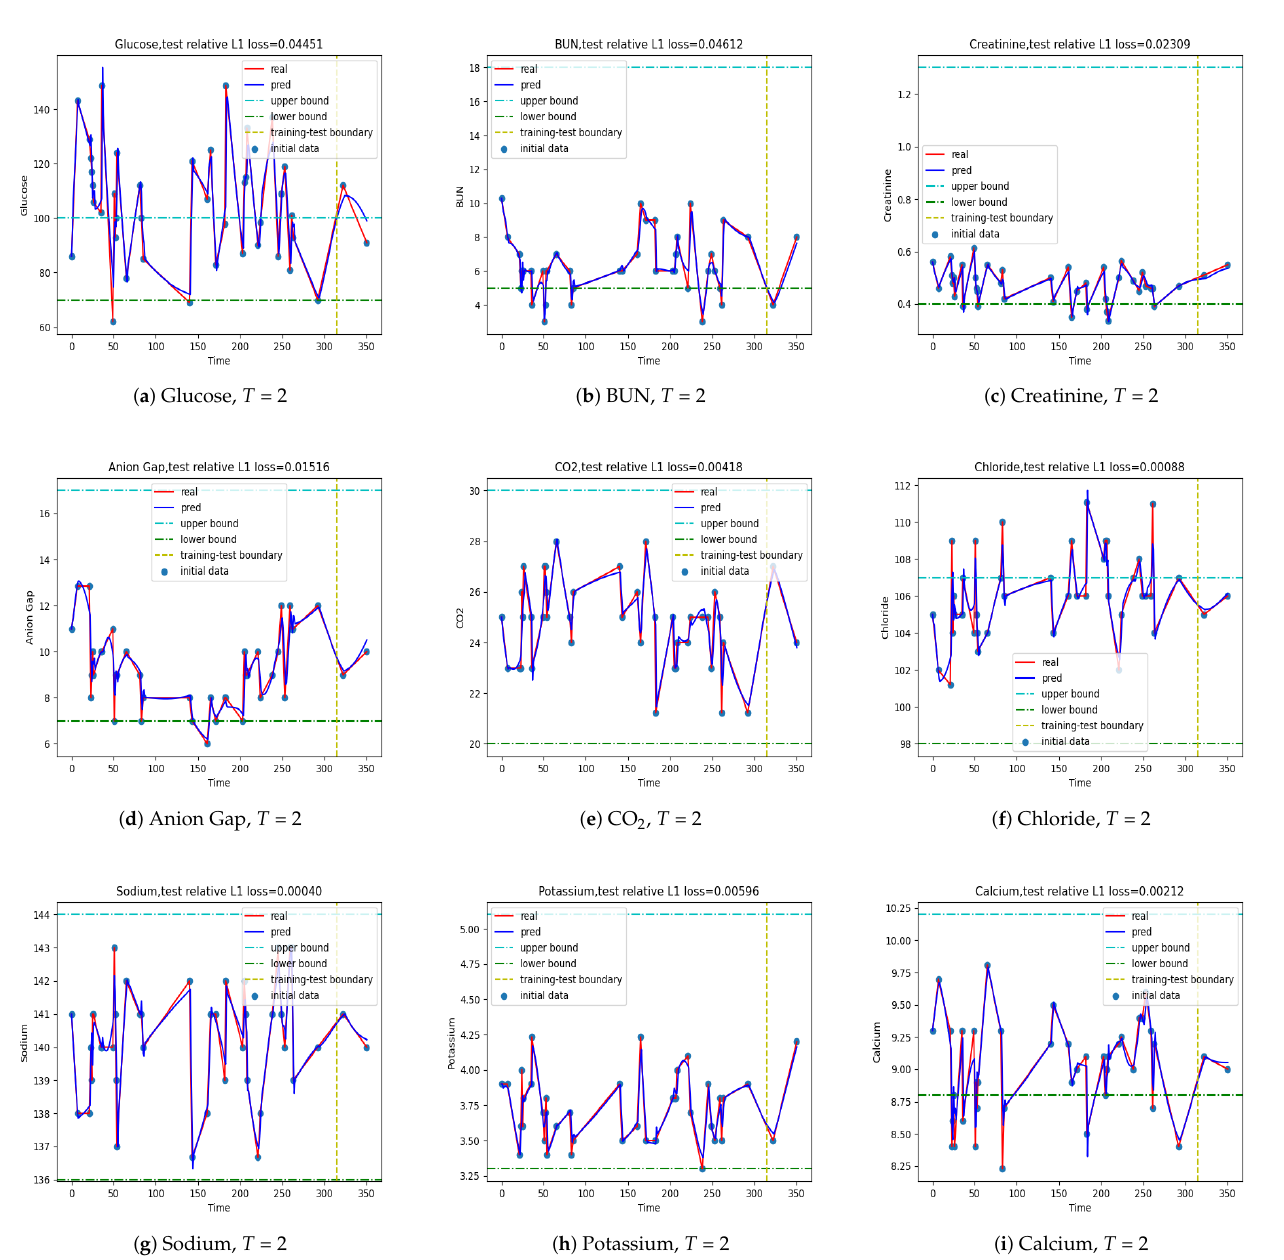
Figure 7. The outputs of the one-step predictive LSTM model for patient ESK with time step T = 2. The values on the right of the vertical line are